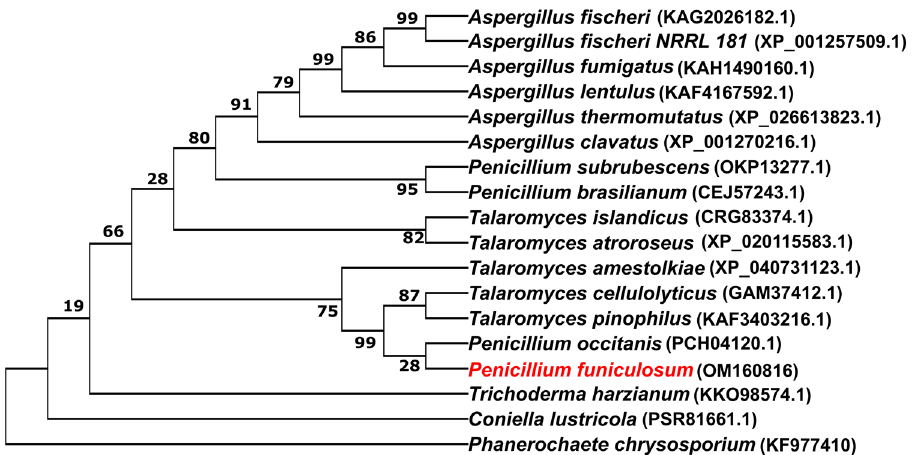
Figure 1. Phylogenetic tree of Pf Xyn5 orthologs in fungi. Molecular phylogenetic analysis was performed using the maximum likelihood method and the JTT matrix-based model. The tree with the highest log likelihood (− 17,992.93) is shown. Initial trees for the heuristic search were obtained automatically by applying neighbor- joining and BioNJ algorithms to a matrix of pairwise distances estimated using the maximum